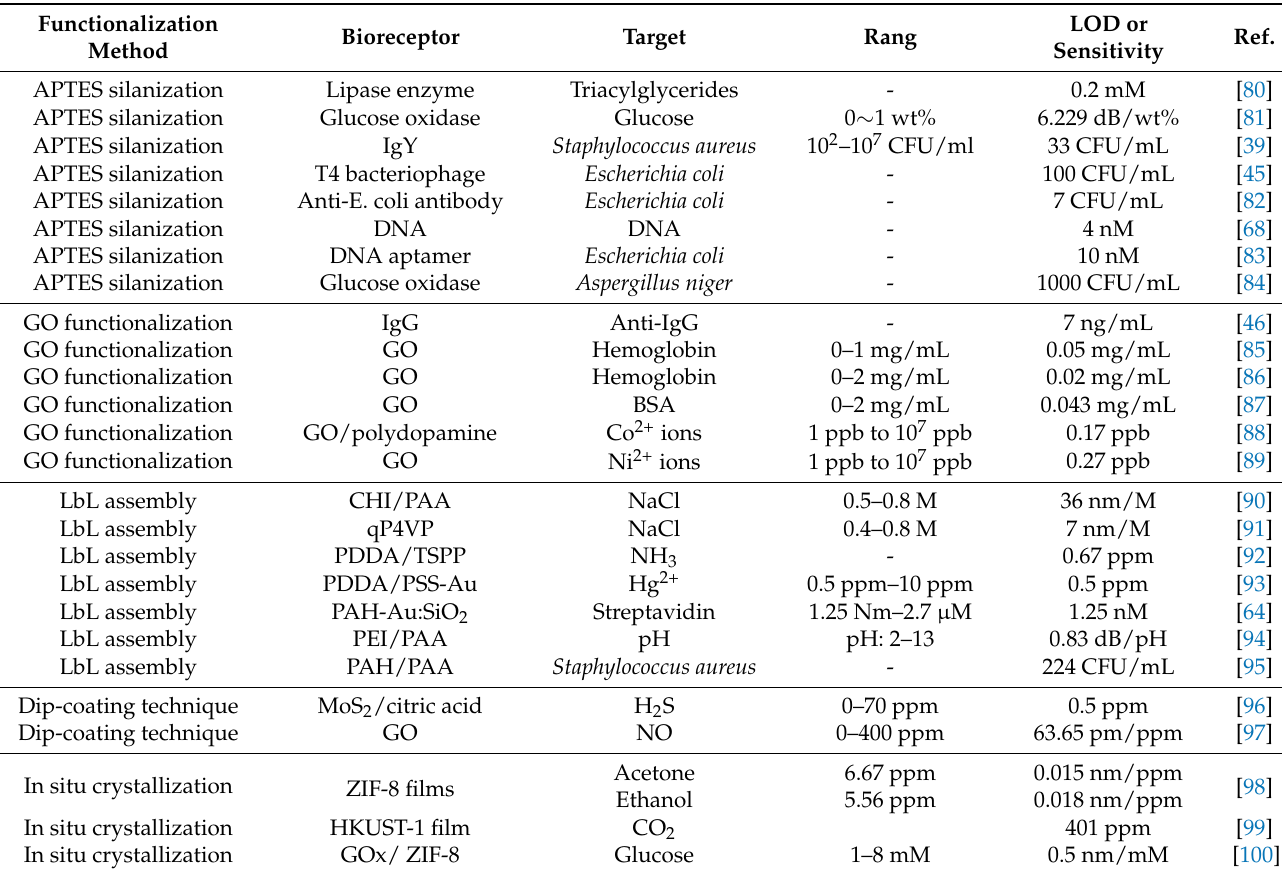
Table 2. Comparison of different reports of the functionalization of LPFG-based